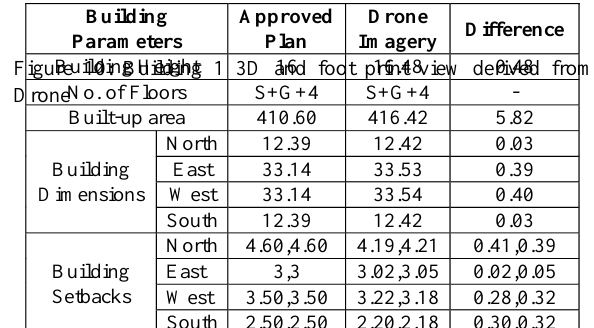
Figure 10: Building 1 3D and foot print view derived from Drone